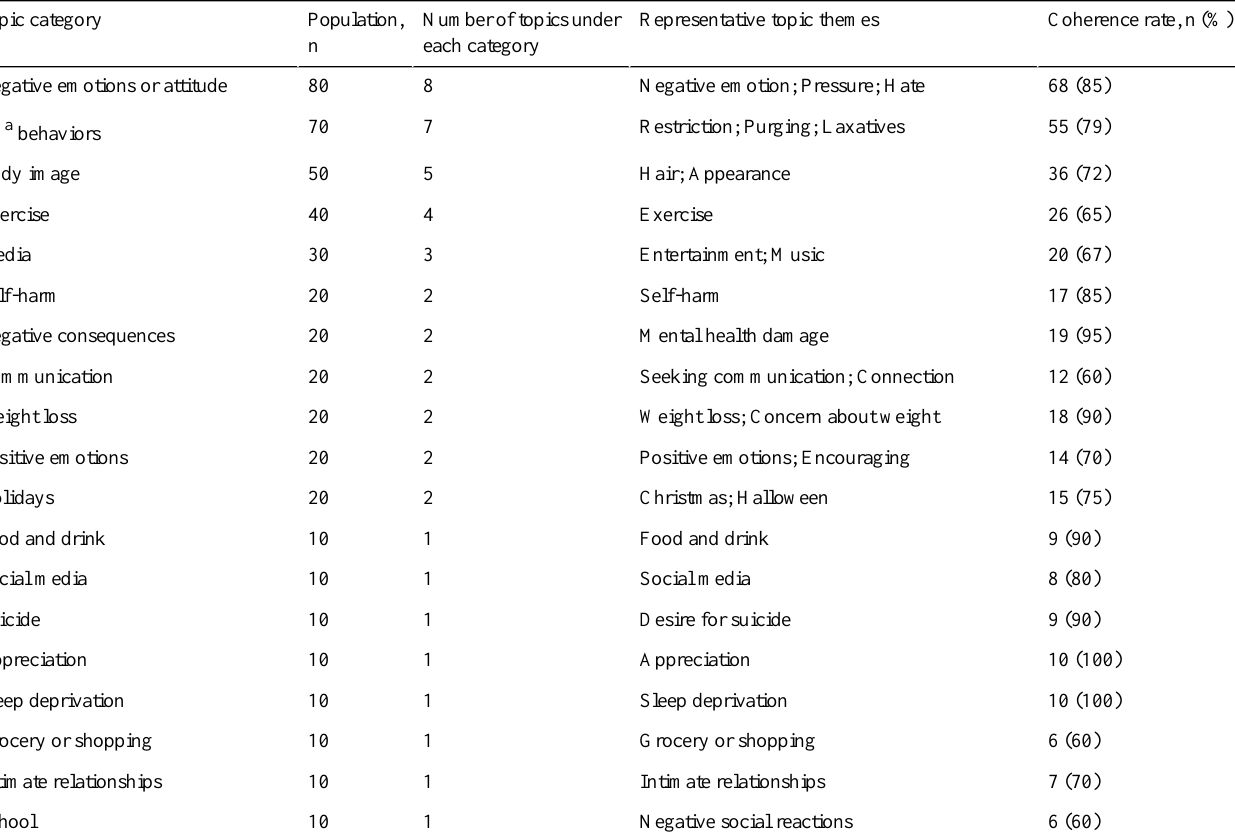
Table 4. A summary of the topics using group 3 tweets (ie, manually identified ED-irrelevant tweets posted by the potential ED users).